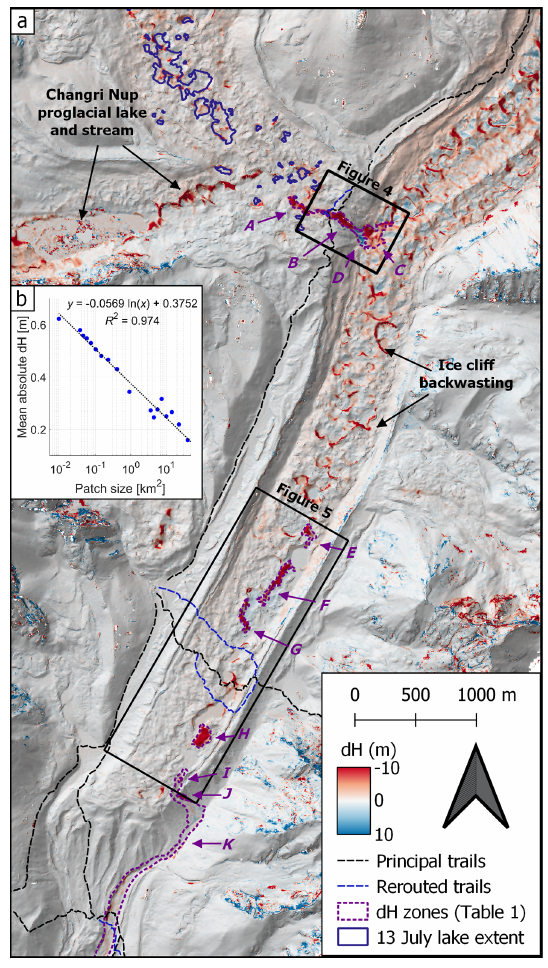
Figure 2. Zones A–K (purple labels) of ablative and geomorphic change associated with the lake drainage as measured by Pléiades March–December DEM differencing, with extents of Figs. 4 and 5 indicated (a) . Error assessment for March–December 2017 Pléiades DEM difference (b)